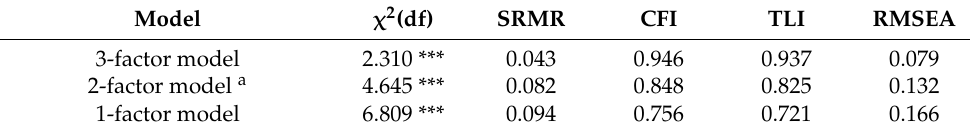
Table 1. Confirmatory factor analysis results.